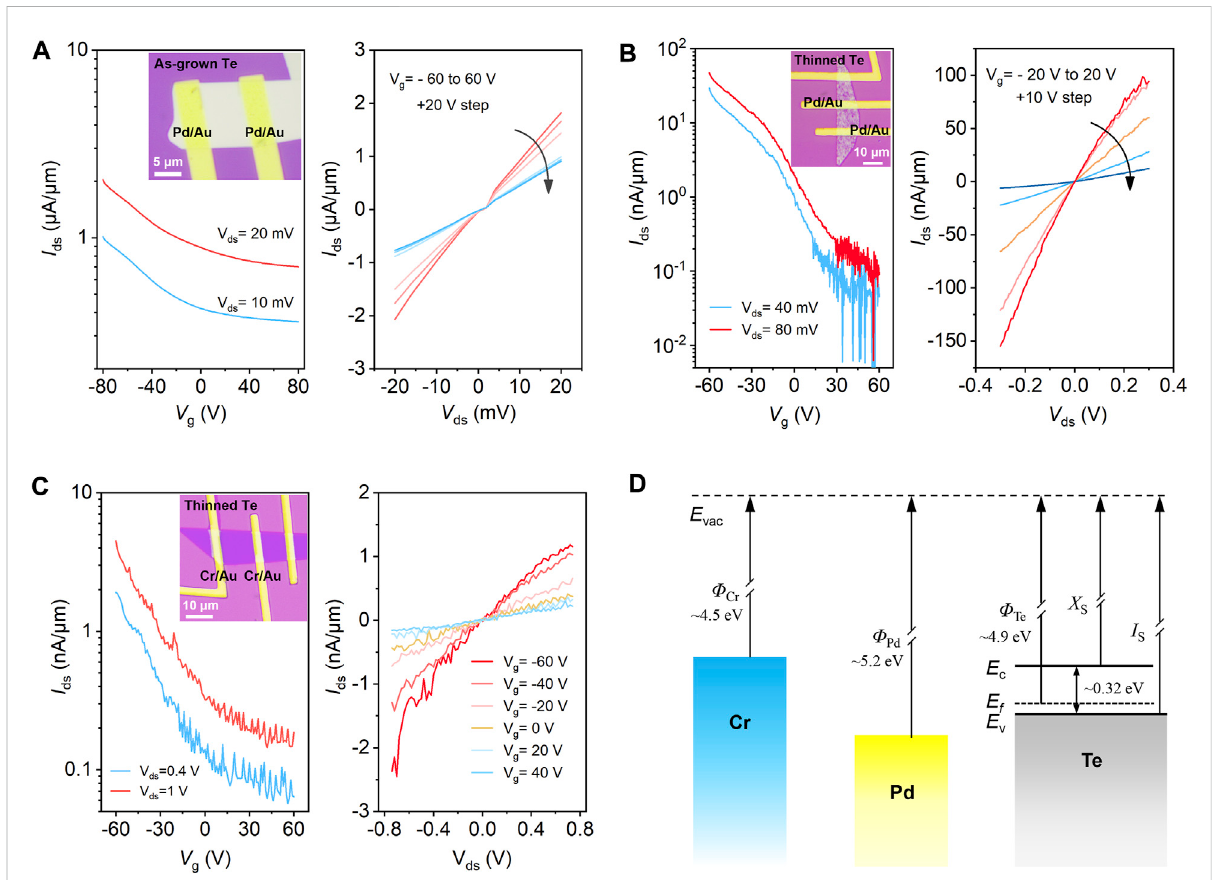
FIGURE 4 Characterizations of the pristine and thinned Te FETs. (A) Transfer and output curves of FET fabricated with as-grown Te nanosheet, and the inset shows the corresponding optical image of the device. (B) Transfer and output curves of FET fabricated with thinned Te. Inset shows the optical image of the device, and Pd/Au is employed as the source and drain electrodes. (C) Transfer and output curves of another thinned Te FET, in which Cr/Au is used as the electrode. (D) Schematic energy band pro fi les for Cr, Pd, and